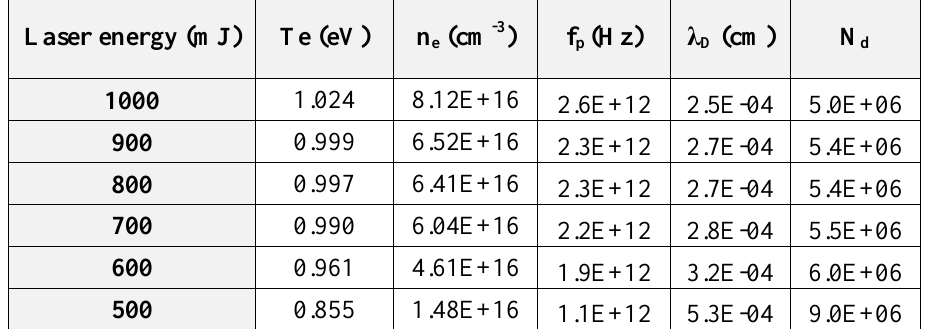
Table 2: Plasma parameters for CuO:Pb at X=0.7 in Vacuum with different laser energy. Laser energy